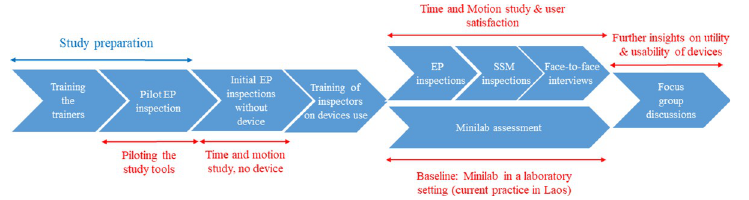
Fig 1. Outline of the field evaluation study. EP: evaluation pharmacy; SSM: Sample set of medicines.